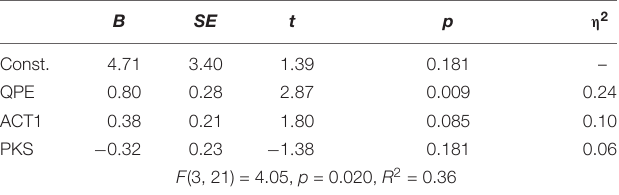
TABLE 6 | Regression results for LM4, Study